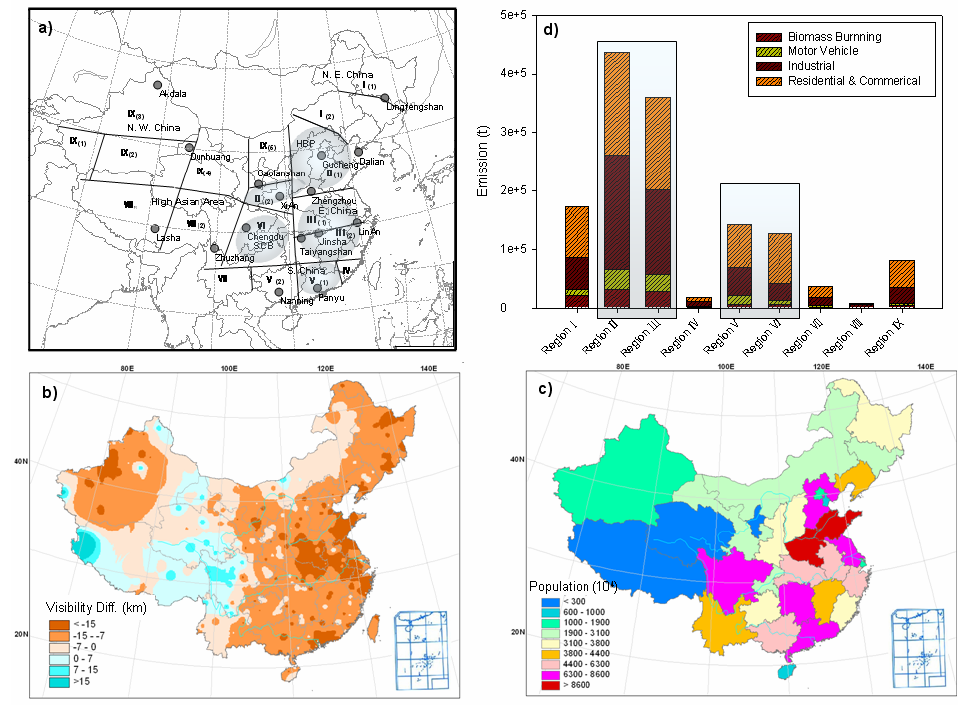
Fig. 11. (a) Nine similar visibility changing regions in China. The four major haze regions are marked with shadow; (b) Differences in five year mean visibilities between 2001–2005 and 1961–1965. Minus value with gradually darker colors represent the loss of visibility; (c) Population during 2001–2005 (NBSC, 2008); (d) Total emission of aerosol and its precious gas from nine regions of China. Original emission data from the reference (Cao et al.,